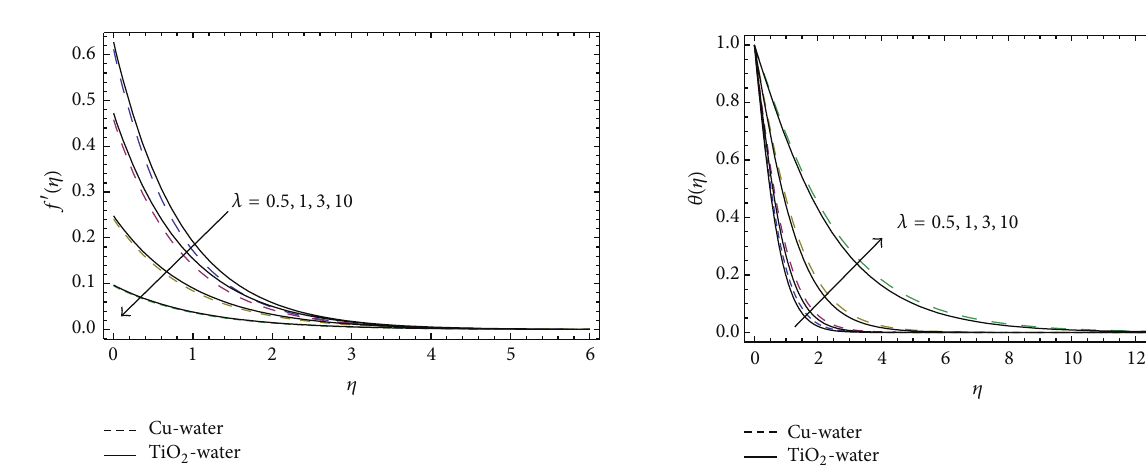
Figure 9: Effect of 𝜆 on the temperature distribution 𝜃(𝜂) for the Cu-water and the TiO 2 -water nanofluids at Pr = 6.2 , 𝑀 = 1 , and 𝜙 = 0.1 .